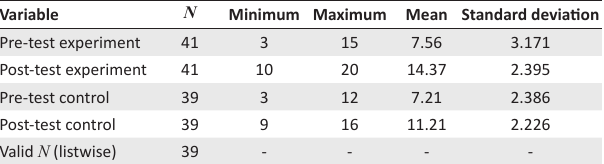
TABLE 3: The descriptive statistics of the experiment group and the control group. Variable N Minimum Maximum Mean Standard